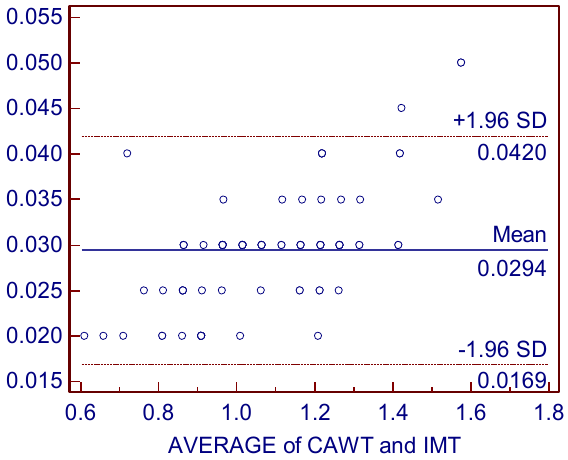
FIGURE 3. Agreement between CAWT measured using MDCTA and IMT measured using CD-US by using Bland–Altman plot. The mean difference and the limits of agreement are also